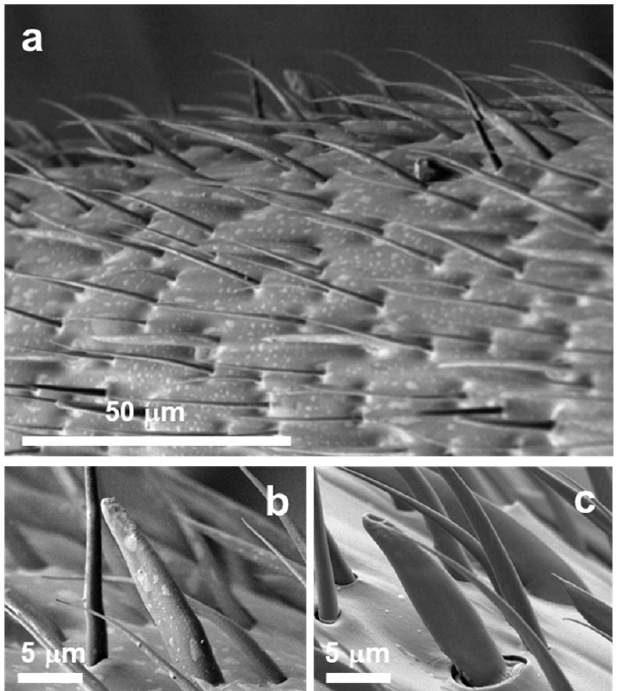
Figure 2. NanoSuit/SEM image of antennal surface and sensillum. Antennal surface ( a ) and a basiconic sensillum in different individual ants at 24 h after the antenna cleaner removal ( b ) and a basiconic sensillum before that ( c ), respectively.